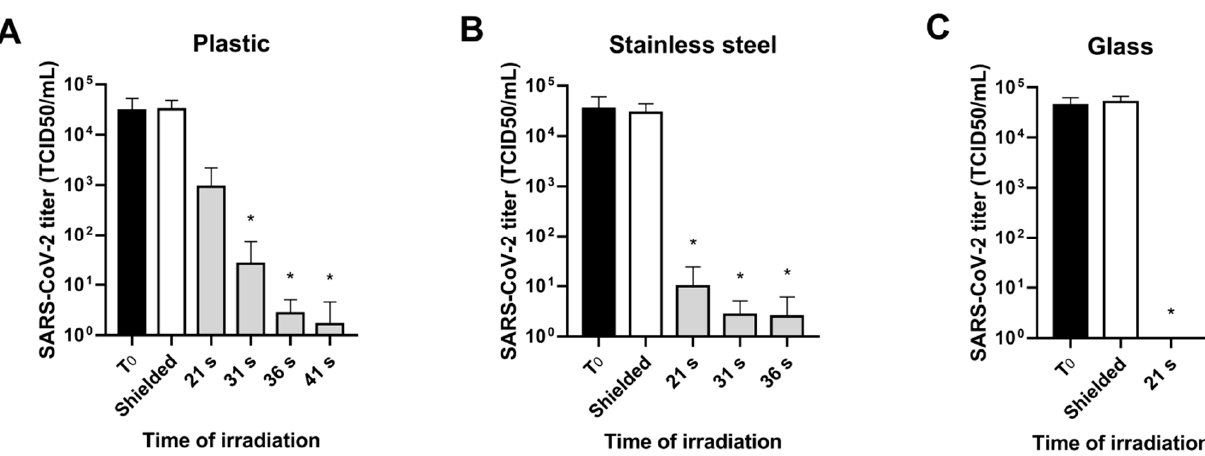
Figure 2. Effect of UV-C light (254 nm) on simulated fomites infection. Ten microliters of SARS-CoV-2 viral stock were placed on ( A ) plastic, ( B ) stainless steel and ( C ) glass, and recovered after 30 min (T 0 ) or exposed to different doses of UV-C (grey bars). After treatments, infectious virus particles were carefully recovered by washings and processed for TCID50 determination. A polystyrene plate covered by aluminum foil served as the control (white bar “shielded”). Results are expressed as the mean ± standard deviation of 3 independent experiments ( n = 3).* p < 0.05, UV-C treated material vs. UV-C shielded.